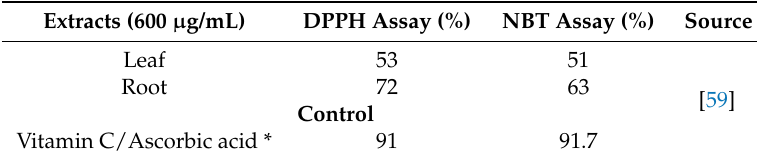
Table 6. The DPPH scavenging and superoxide scavenging activity determined by DPPH [82] and NBT assay [83].